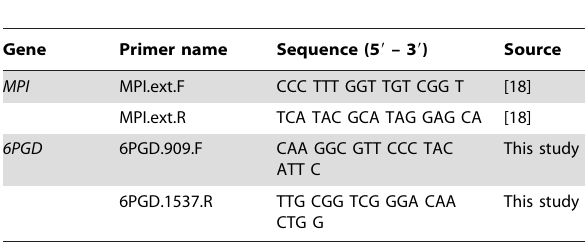
Table 1. Primers used in the conventional PCR assays for MPI and 6PGD genes carried out prior to the nested real-time PCR